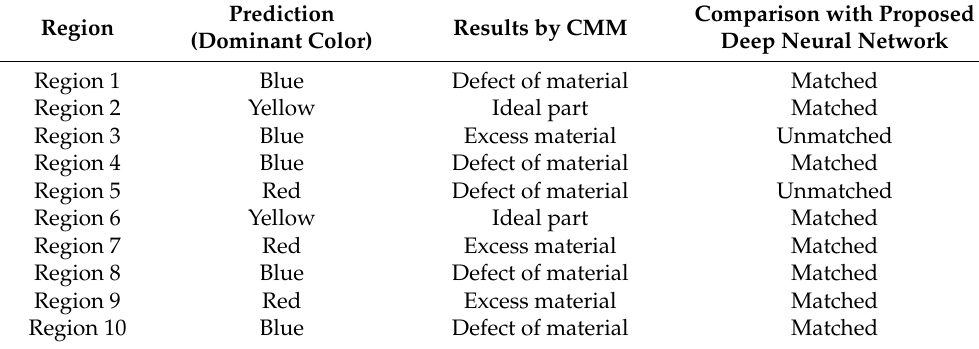
Table 5. Comparison of results between the current method (CMM) and the proposed deep neural network for defect monitoring.